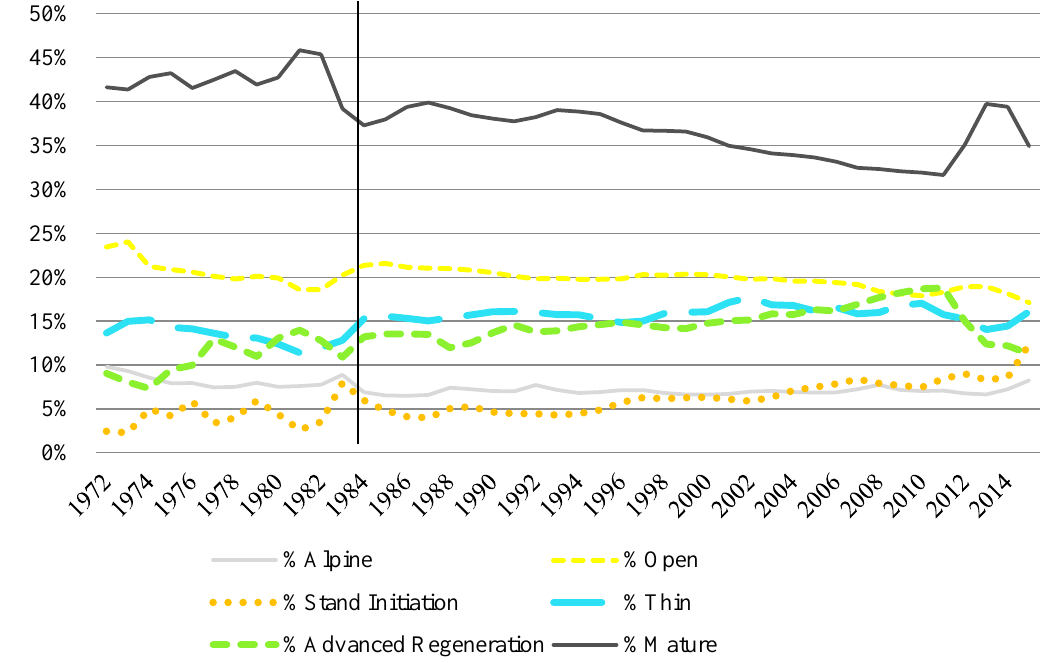
Figure 6. Time series trajectories of six forest structure classes from 1972 to 2015. Percentage of study area of each class for each year is shown on the Y-axis. For instance, Mature has lost area overall, starting with 42% of the study area in 1972 and ending with 35% of the study area in 2015. The transition from MSS to TM data is shown at the 1984 mark.